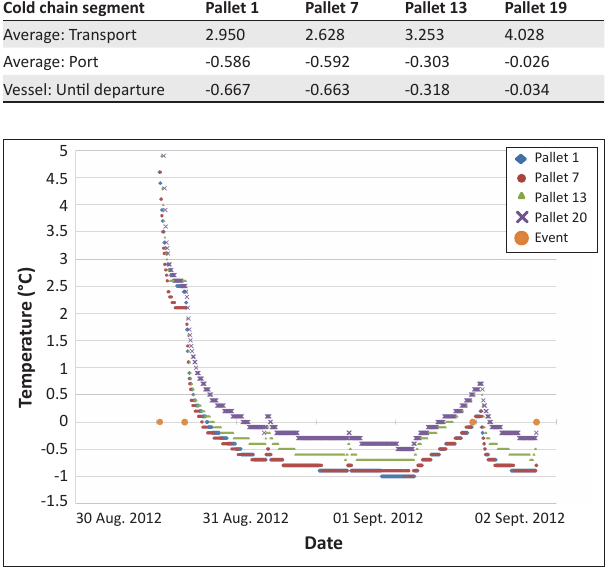
FIGURE 3: Ambient temperature from the cold store to the